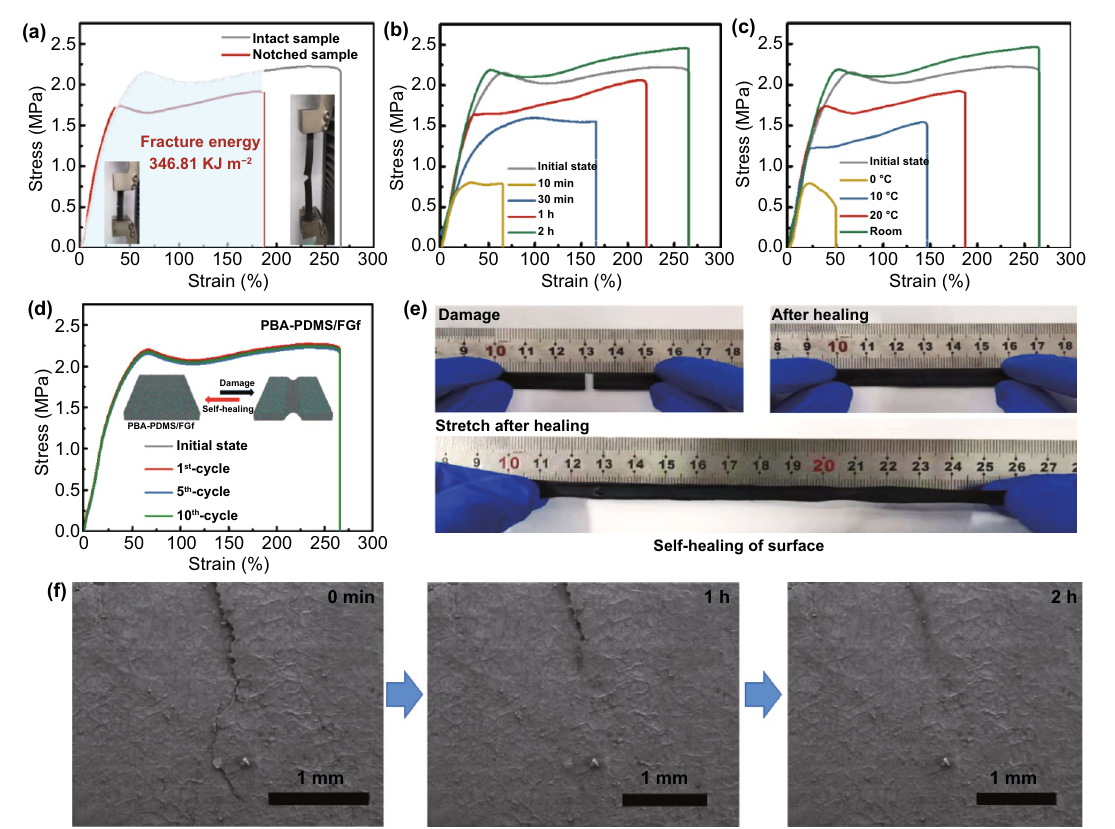
Fig. 3 a Stress–strain curves for structurally complete and single-sided notched PBA–PDMS/FGf elastomers. The inset images show the elas- tomer at 180% strain (left) and 270% strain (right). b Stress–strain curves of the PBA–PDMS/FGf at room temperature for different healing durations (10 min, 30 min, 1 h, and 2 h). c Stress–strain curves of PBA–PDMS/FGf at different temperatures (0, 10, 20, and 25 °C) for 2 h. d Stress–strain curves of PBA–PDMS/FGf with 10 self-healing cycles at room temperature for 2 h. e Healing digital photographs and elasticity demonstration of the fractured PBA–PDMS/FGf elastomer. f Surface morphology images of the healed PBA–PDMS/FGf samples at room tem- perature for 0–2